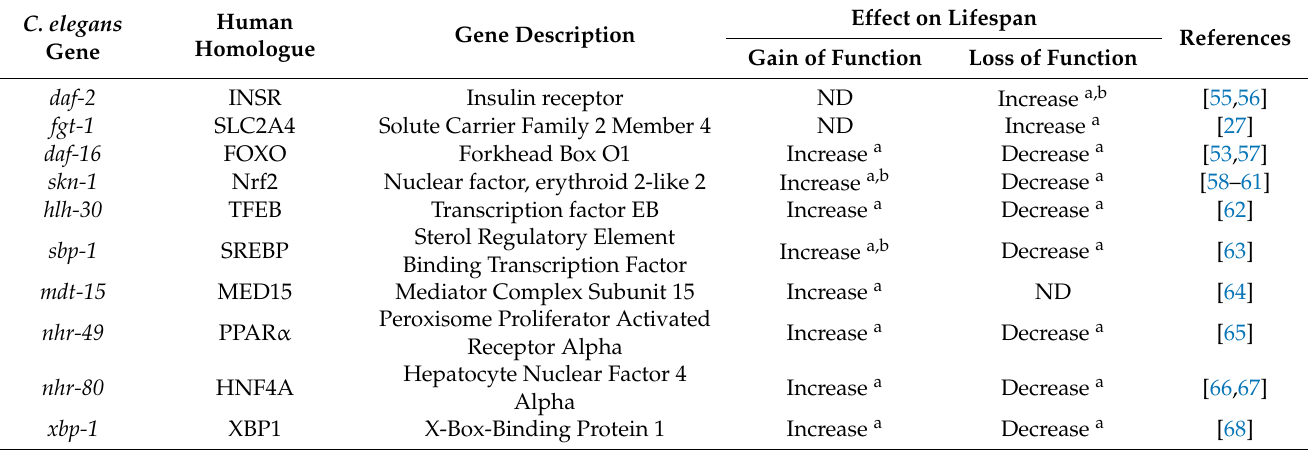
Table 1. List of genes that alter the lifespan in C. elegans and